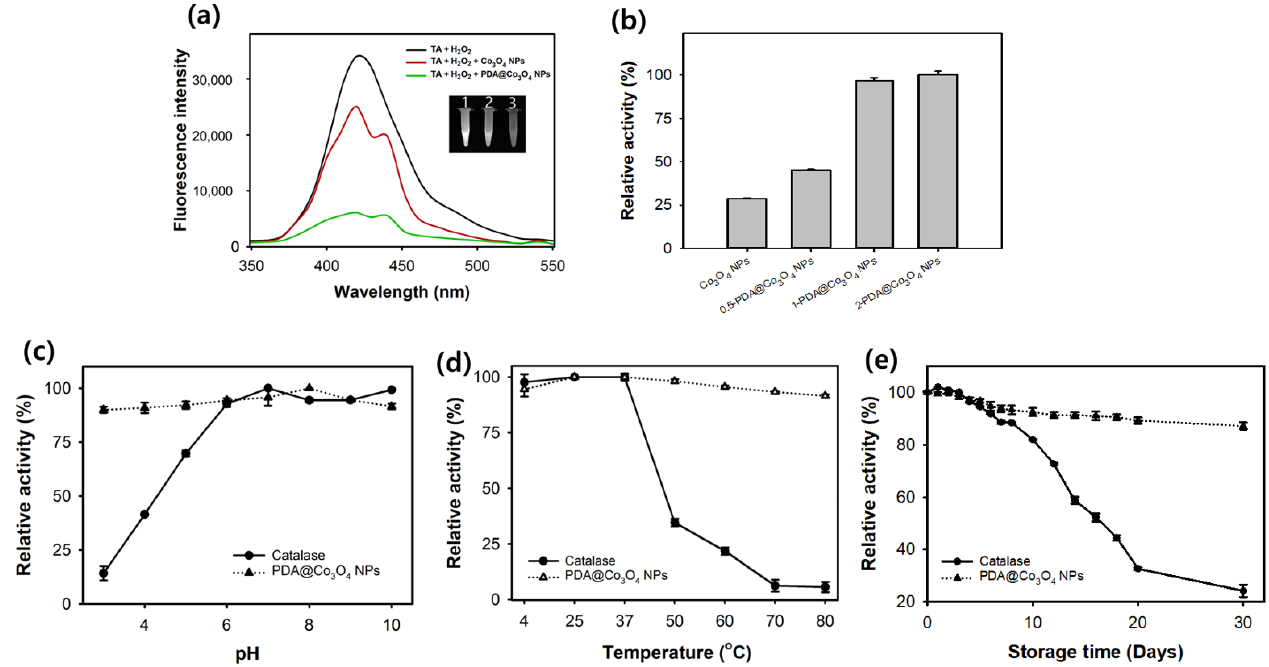
Figure 4. Evaluation of the catalase-like activity of PDA@Co 3 O 4 NPs. ( a ) Catalase-like activity of bare Co 3 O 4 NPs (red line) and PDA@Co 3 O 4 NPs (green line). Insert fluorescent image indicates (1) control, (2) bare Co 3 O 4 NPs, and (3) PDA@Co 3 O 4 NPs. ( b ) Comparison of the catalase-like activity among 0.5-PDA@Co 3 O 4 NPs, 1- PDA@Co 3 O 4 NPs, and 2-PDA@Co 3 O 4 NPs. Comparisons of the sta-